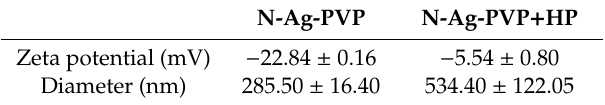
Table 2. Analyses of zeta potential and DLS changes of N-Ag-PVP and N-Ag-PVP +